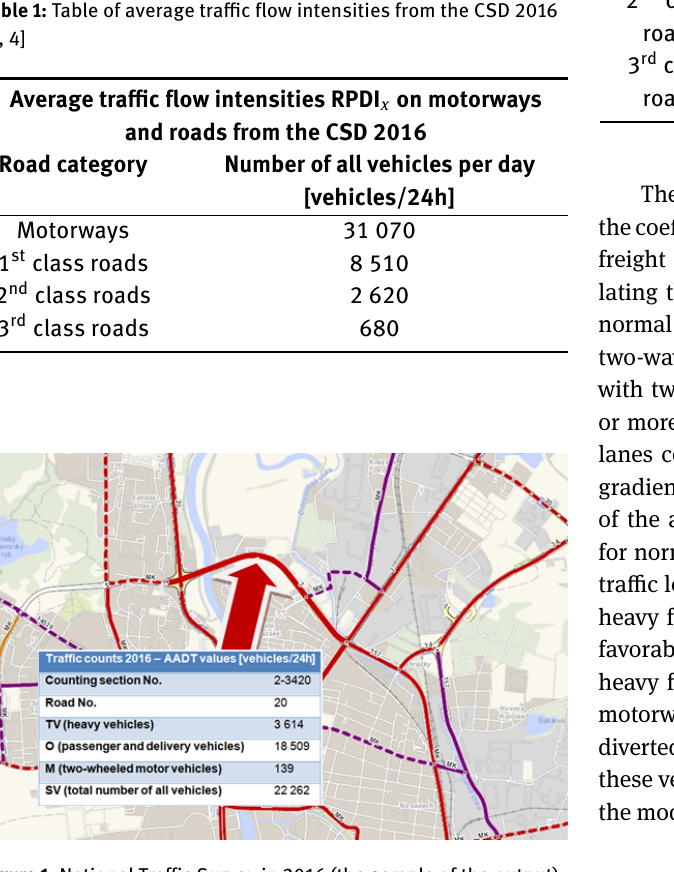
Figure 1: National Traflc Survey in 2016 (the sample of the output) [3]